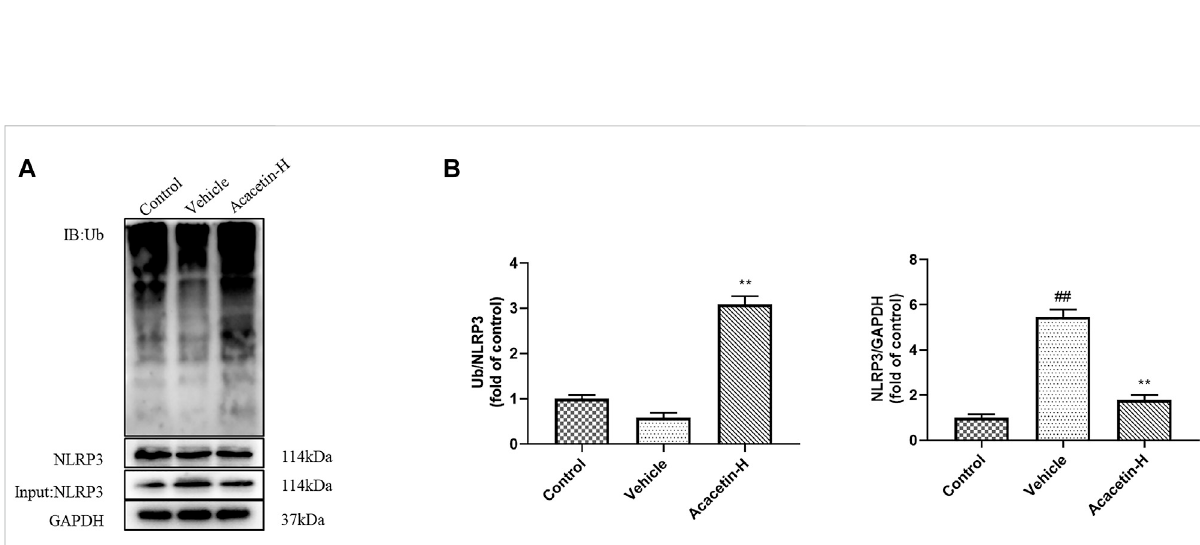
FIGURE 3 Effect of acacetin on NLRP3 ubiquitination in the hippocampus. (A) The ubiquitination of NLRP3 in the hippocampus of mice was detected by co-immunoprecipitation (co-ip). (B) Quanti fi cation of ubiquitinated NLRP3 expression levels and NLRP3 protein expression in the hippocampus of mice. Results are expressed as the mean ± SEM ( n = 3 per group). ## p < 0.01 vs. Control; ** p < 0.01 vs.